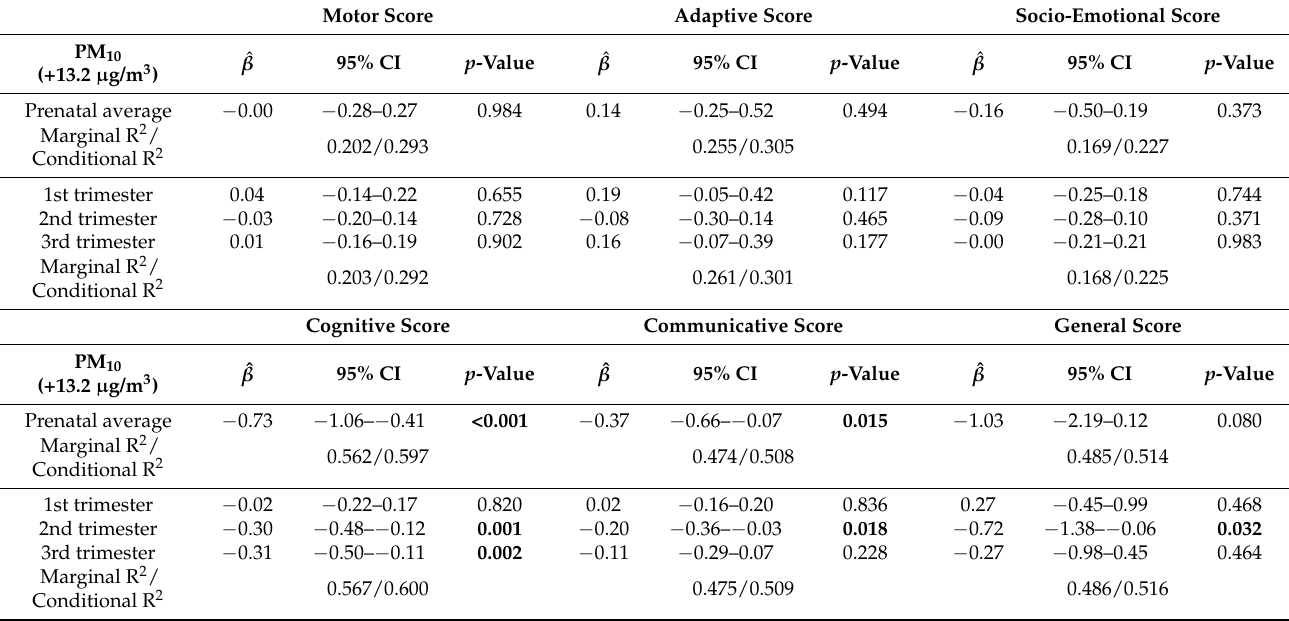
Table 3. Adjusted * estimates of the coefficients for PM 10 concentration, overall and for each trimester of pregnancy, for each domain of interest by robust ME models. Bold values denote statistical significance at the p < 0.05